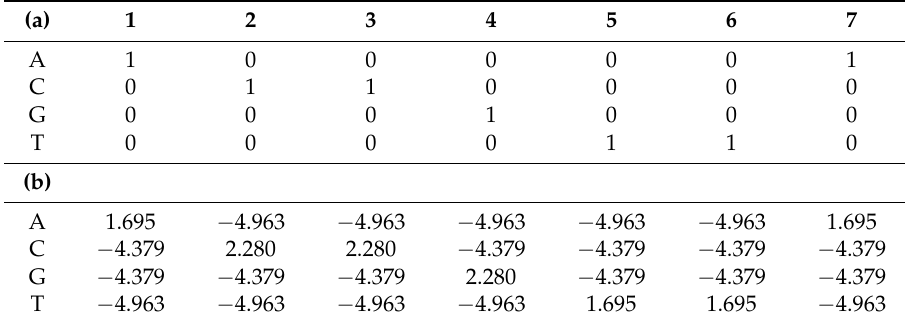
Table 2. A matrix representation of sequence “ACCGTTA” (a). The resulting position weight matrix (b) is obtained after adding a pseudocount of 0.01 to each cell in (a), with background frequencies being 0.3, 0.2, 0.2, and 0.3 for A, C, G, and T,